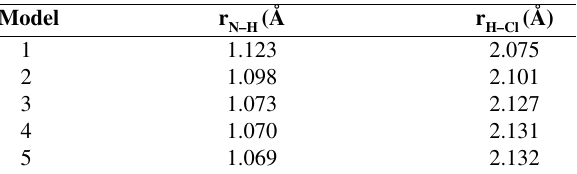
Table 7. Structural parameters for Alanine hydrochloride clusters optimized with M06-2X/6-31++G(d,p) method. Model